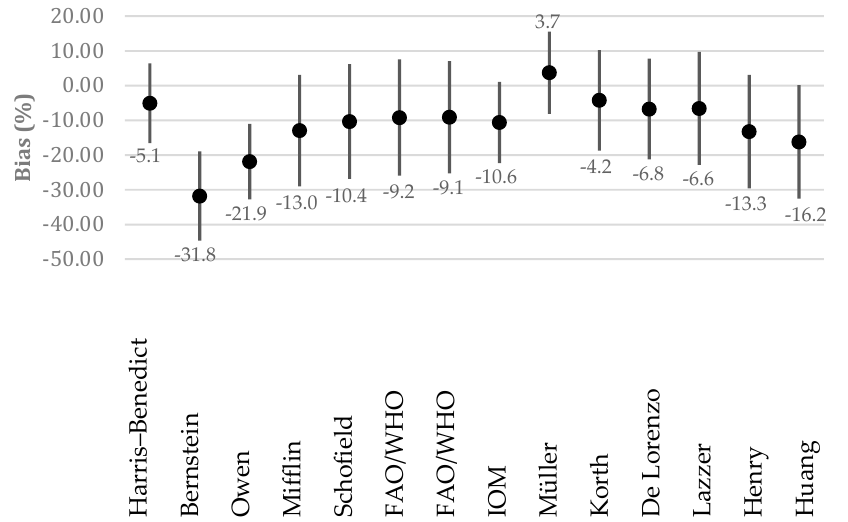
Figure 1. Percent bias of equations for the predicted REE compared with estimated REE (mean ± standard deviation).